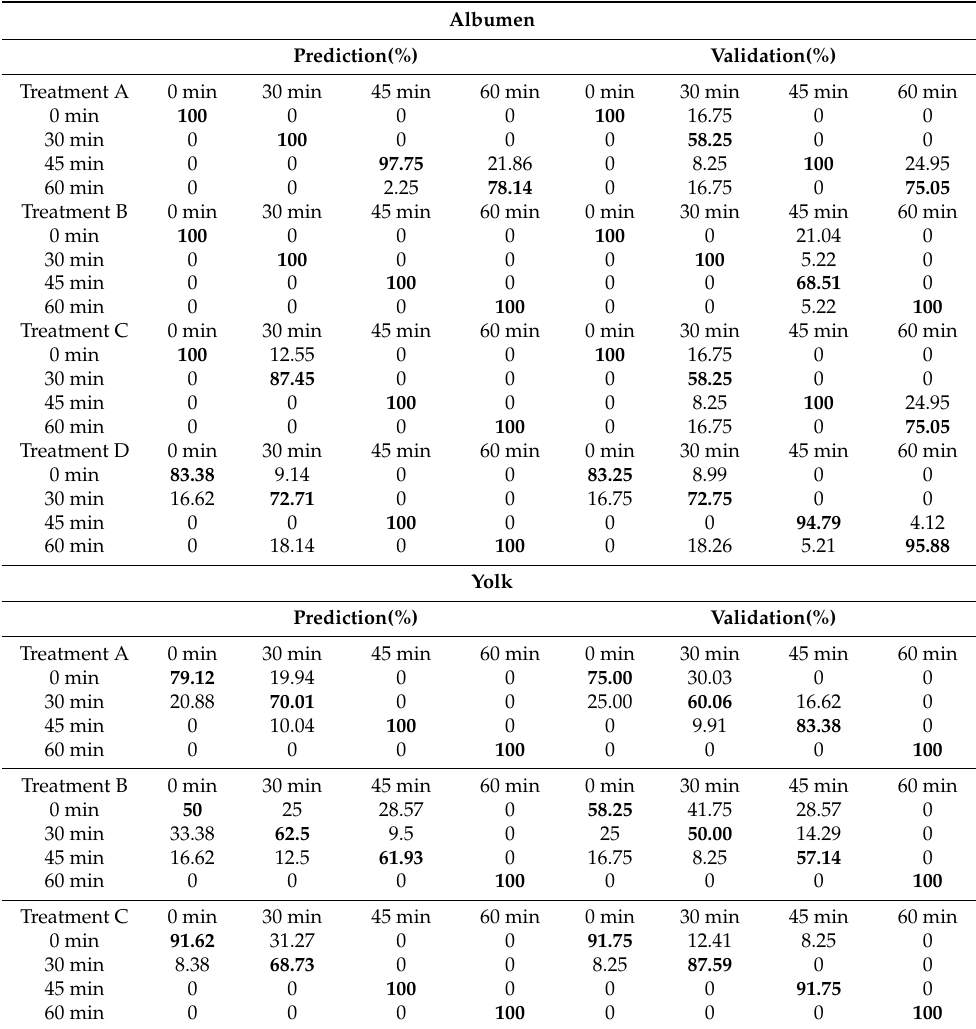
Table 4. Classification table of the acquired linear discriminant analysis (LDA)